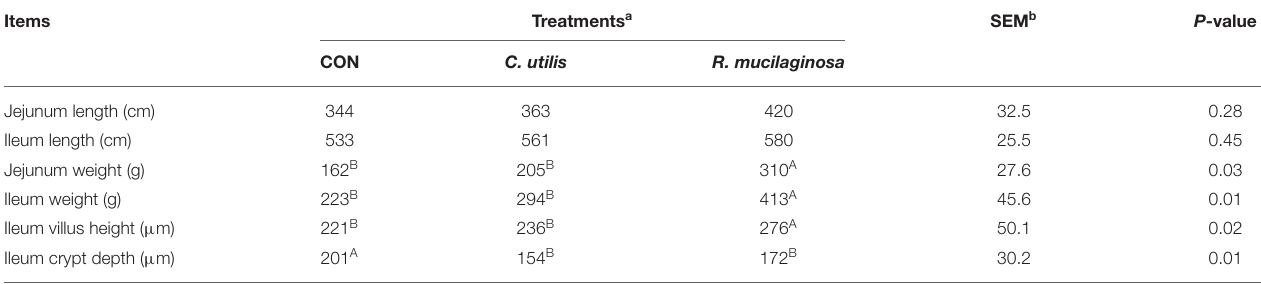
TABLE 6 | Effects of C. utilis DSM 2361 and R. mucilaginosa TZR 2014 on intestinal structure in weaned piglets ( n = 5).